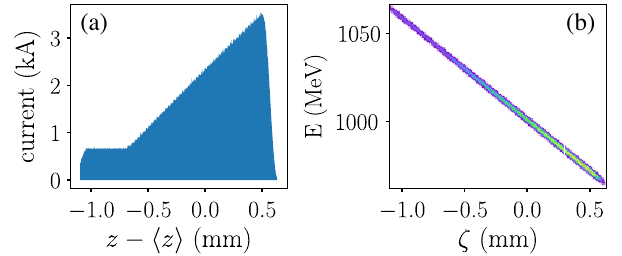
FIG. 2. A target drive bunch peak current (a) and longitudinal phase space (b) distributions at the end of the drive bunch accelerator.